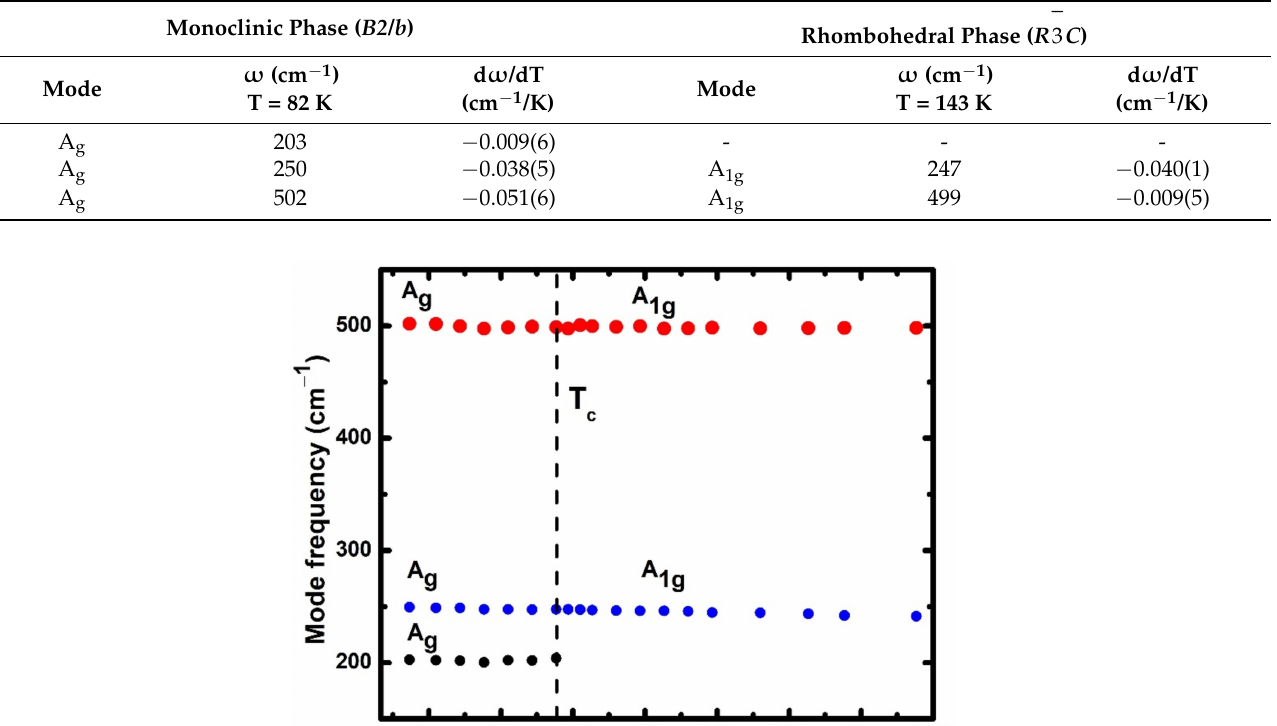
Table 2. Here, one can see the Raman mode frequencies and temperature coefficients in various phases of the V 2 O 3 thin films. The number in the parenthesis indicates the standard error in the least significant digit.